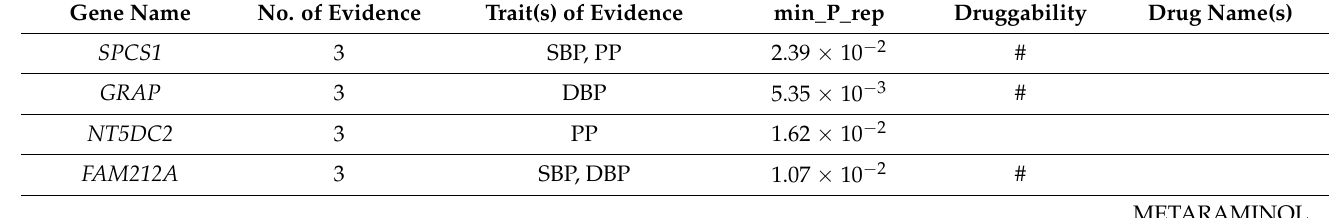
Table 2. Summary of the 28 newly identified genes and their replication in the MVP cohort using TWAS